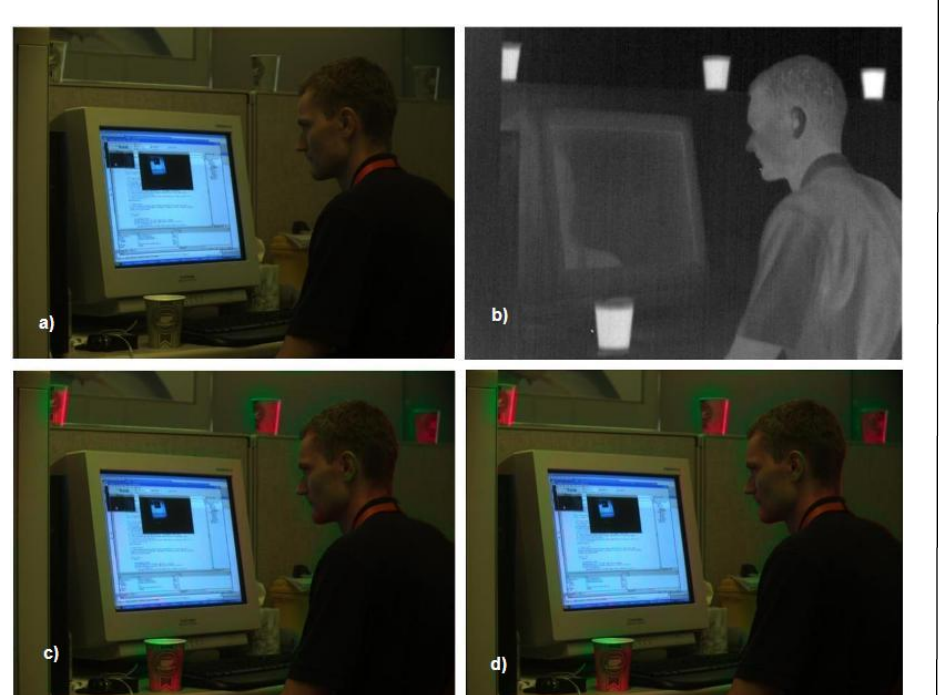
Figure 12 – Color image fusion of an indoor sequence. a) and b) true color and IR inputs, c) and d) fusion results using the l αβ color system method without and with structural